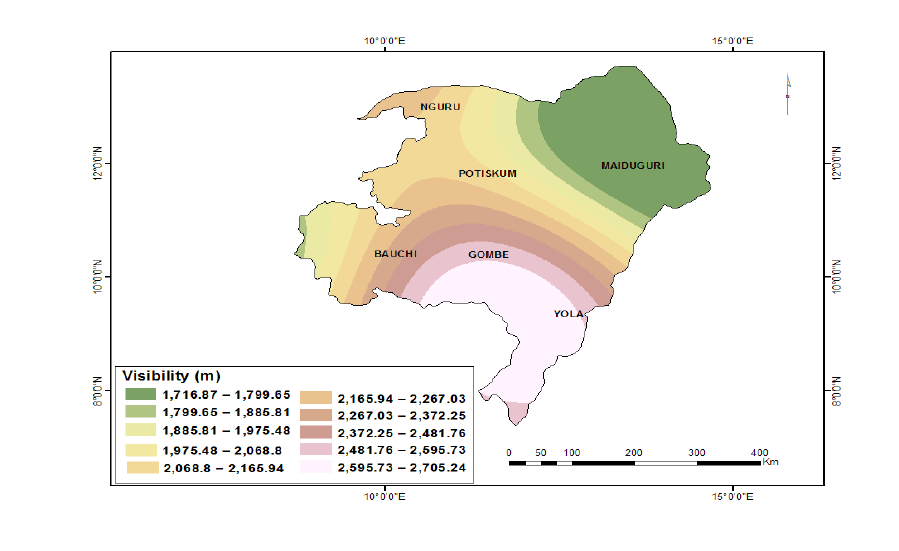
Figure 9: Spatial visibility distribution in Northeastern Nigeria (1984/1985 – 1988/1989).